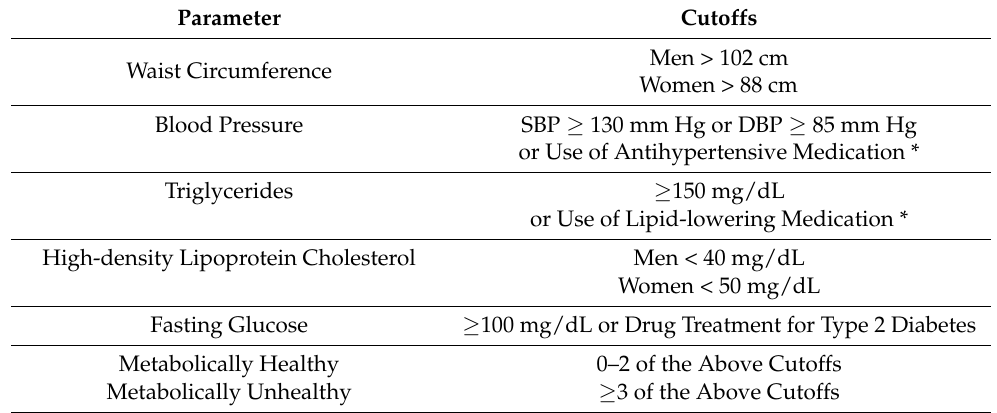
Table 1. Definition of metabolic health (International Diabetes Federation (IDF)/AHA/NHLBI,